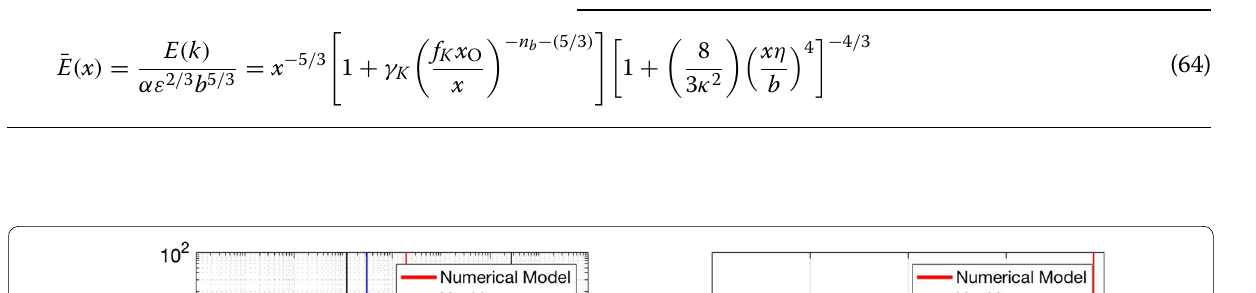
Fig. 4 Assumed spectral shape, log scale (left) and linear (right) for σ = 0.1 m/s and ε = 0.47 σ 3 L with L can be changed and spectral shape replotted using the code provided. Note how the energy is concentrated at low wavenumbers, and therefore, the spectral shape in the ISR and beyond is important. Note also the difference relative to Hocking’s spectrum (Eq. 66) in the BSR and